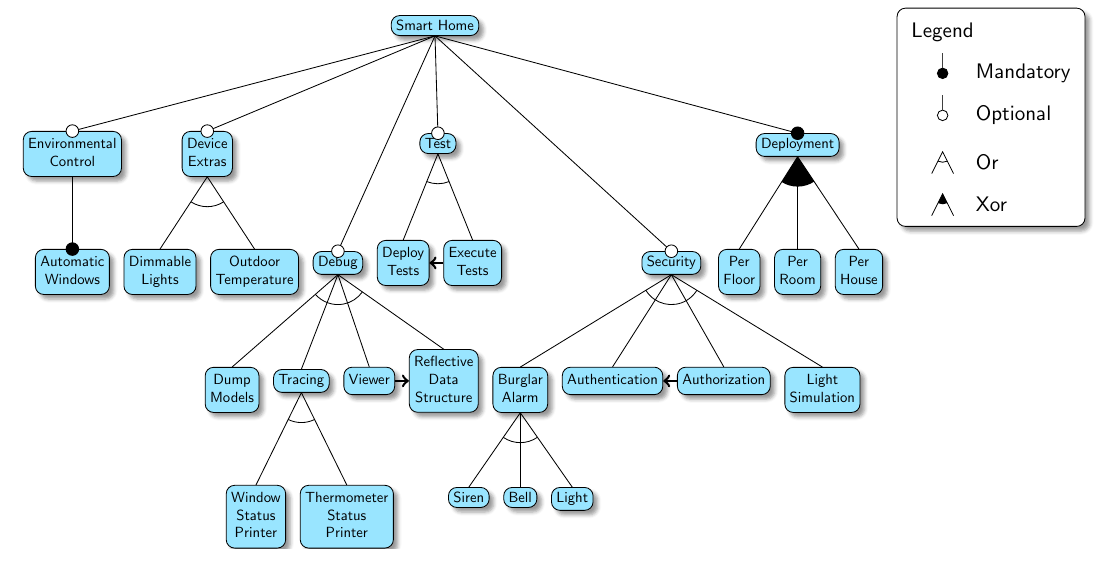
Figure 1. A feature model for a Smart Home